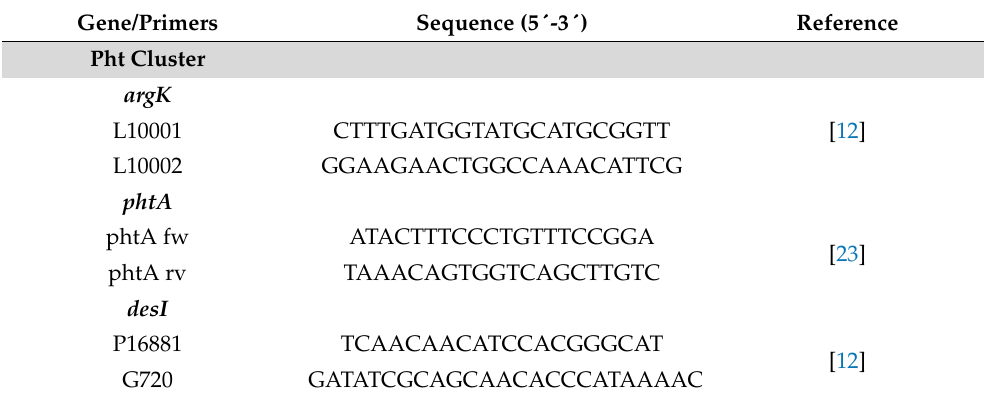
Table 1. The PCR primers used in this